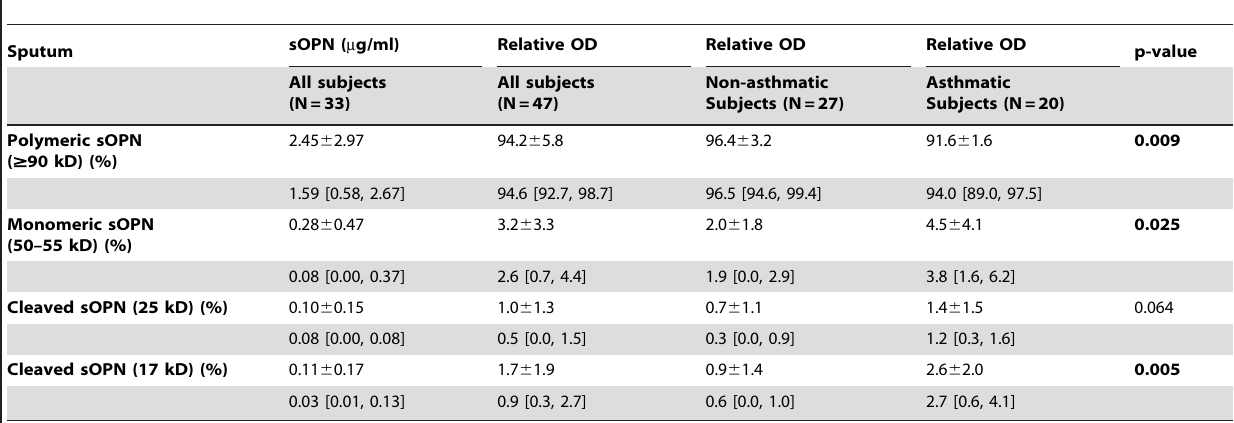
Table 2. Relative optical density (OD) for sOPN bands and OD-based concentration of sOPN in sputum.